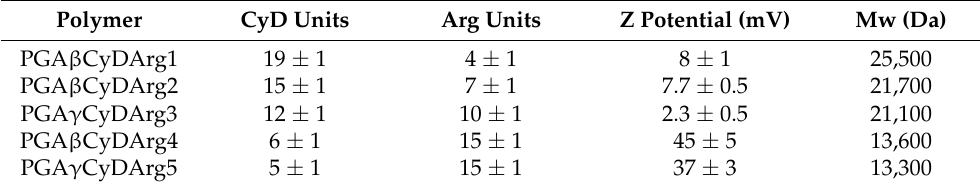
Table 1. Features of PGA-CyD-Arg